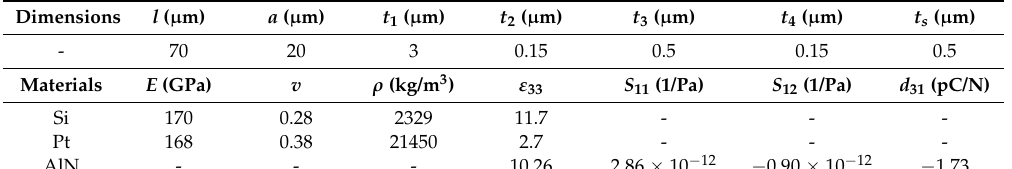
Table 2. Specific structural and material parameters of the single-element DFUT.